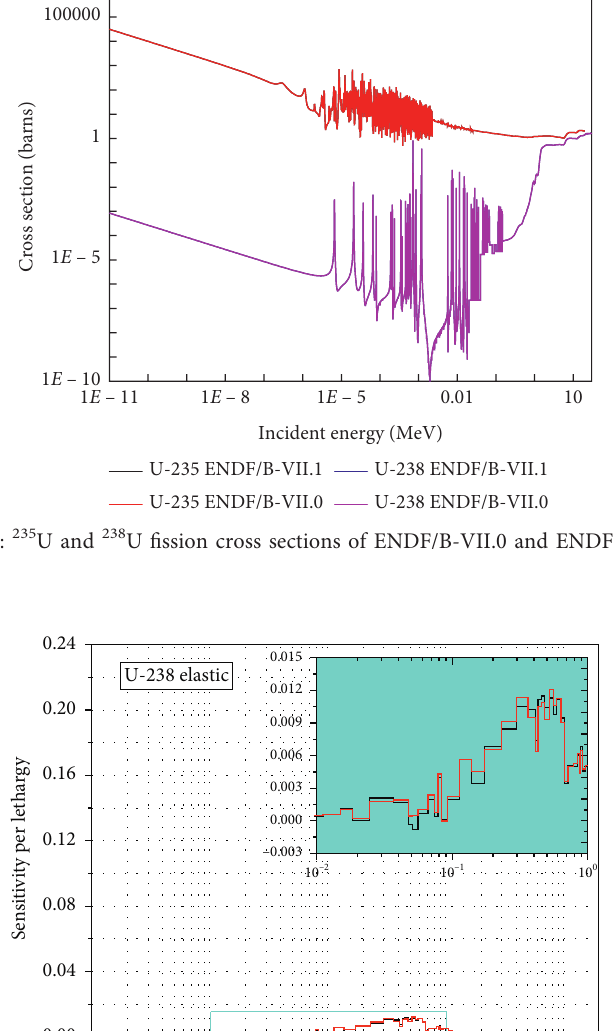
to 238 U elastic scattering cross eff